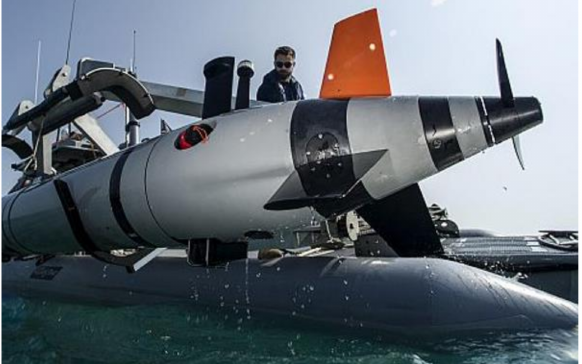
Figure 1. Control surfaces and propellor on unmanned underwater vehicles [7] utilizing typically available DC motors [8,9].